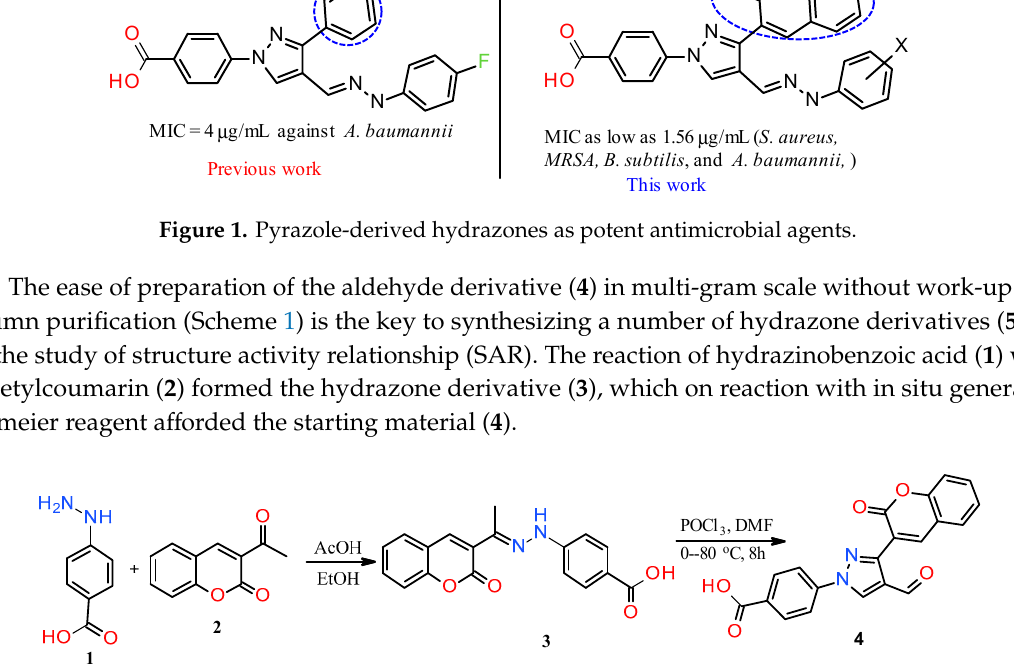
Scheme 1. Synthesis of coumarin-substituted pyrazole aldehyde.